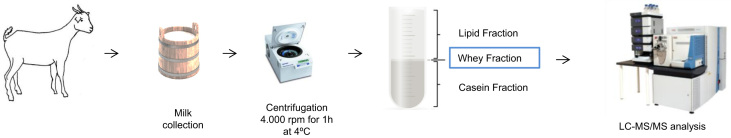
Flowchart of the strategy followed for analysis of milk. Following sample preparation the milk whey proteome was analyzed by nanoLC-MS/MS.